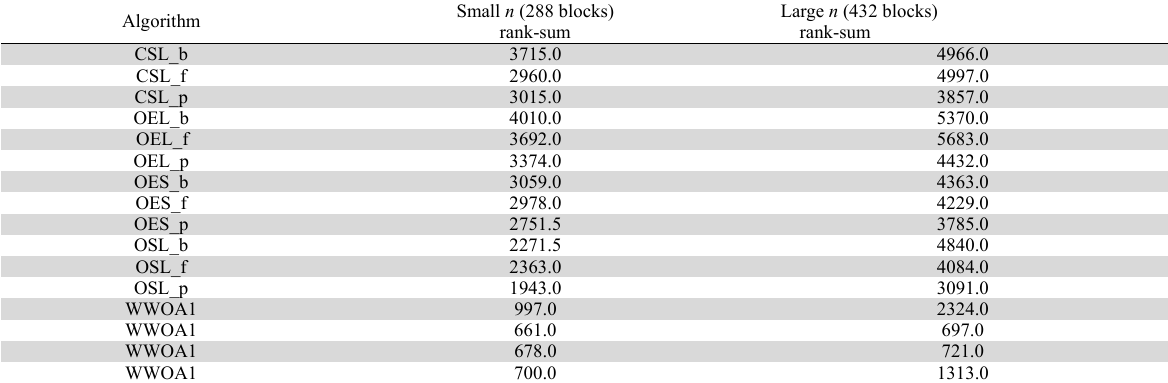
Rank sums of AEP and RPD for 12 heuristics and 4 WWO algorithms to make multiple comparisons. Algorithm